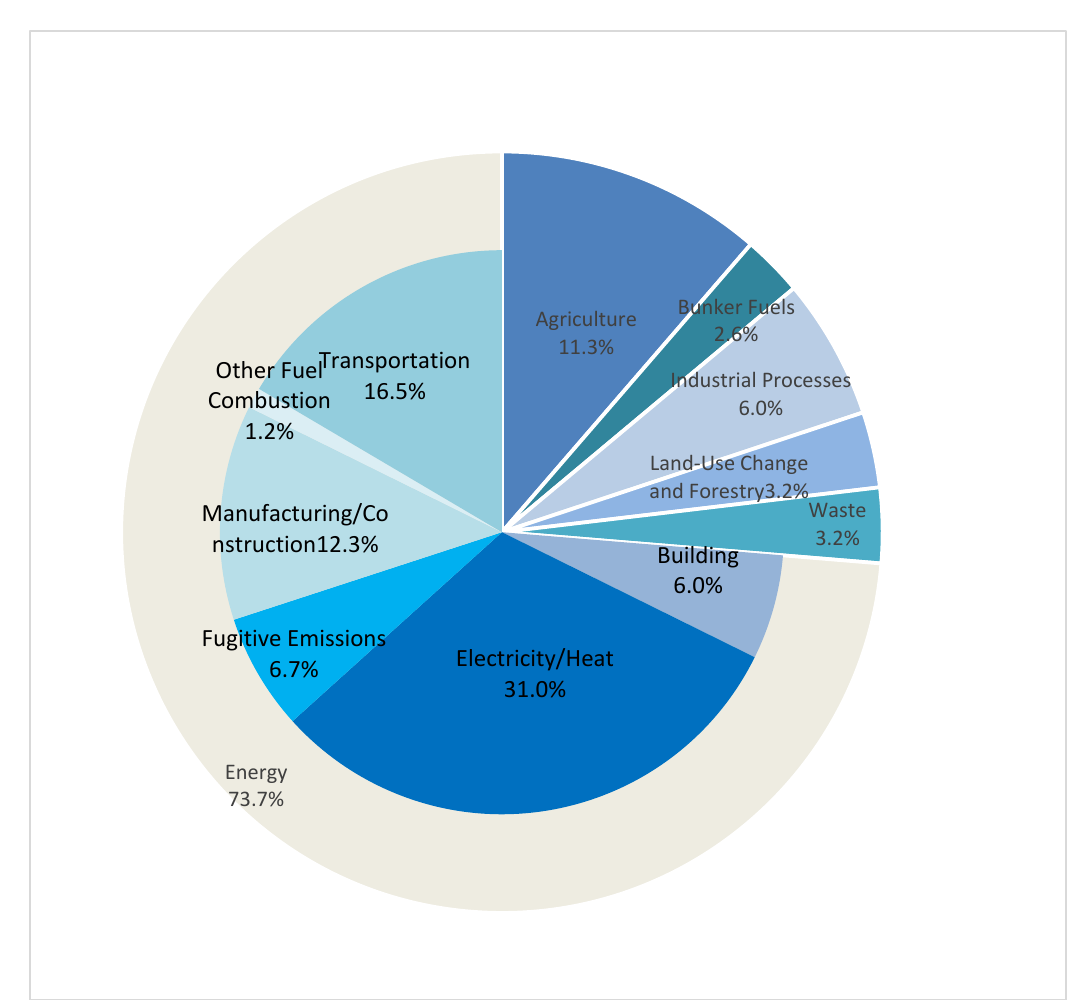
Figure 1. Proportion of global greenhouse gas emissions by sector (%). Source: Climate Watch. Historical GHG Emissions.